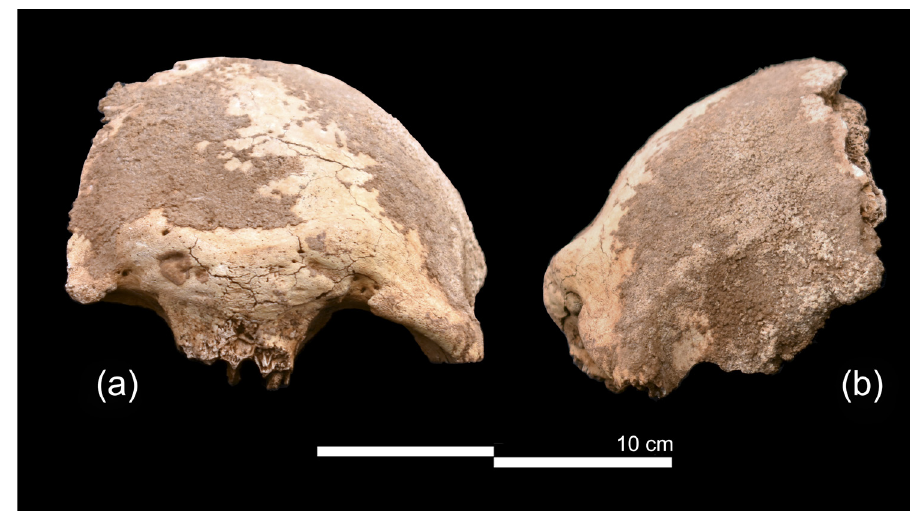
Figure 4: ( a ) View in norma frontalis of the frontal bone 7001 and ( b ) view in norma lateralis